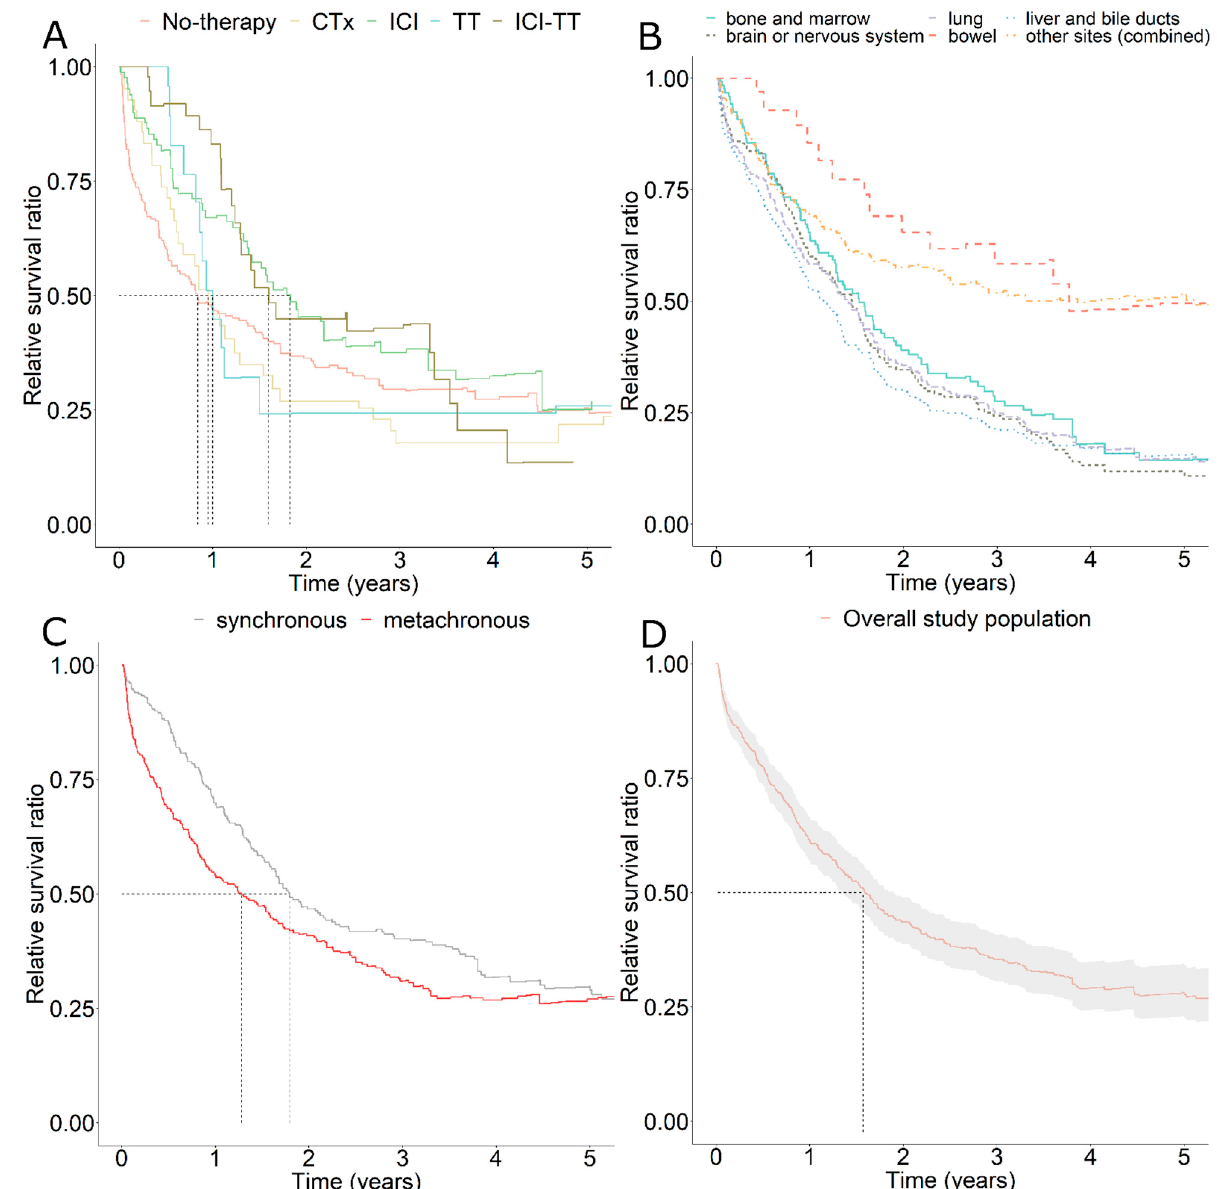
Figure 1. Relative survival of metastatic melanoma patients since first metastasis compared to the background mortality of all Saxon residents ( A ) depending on the therapy received. The subgroups with certain therapies were exclusive and no other combinations except ICI and TT were displayed. CTx: chemotherapy, ICI: Immune Checkpoint Inhibitor therapy, TT: Targeted therapy, ICI-TT, ICI, and TT in sequential use (order not considered); Relative survival ( B ) depending on the localization of distant metastases (five common sites and a sixth subgroup with the remaining localizations of metastases) or ( C ) depending on the time of occurrence of the metastases (synchronous vs. metachronous). ( D ) Relative survival of the total cohort studied. Risk tables for subgroups and time points (yearwise) were given respectively below each graph. Median survival time for each curve were indicated with a dashed line.